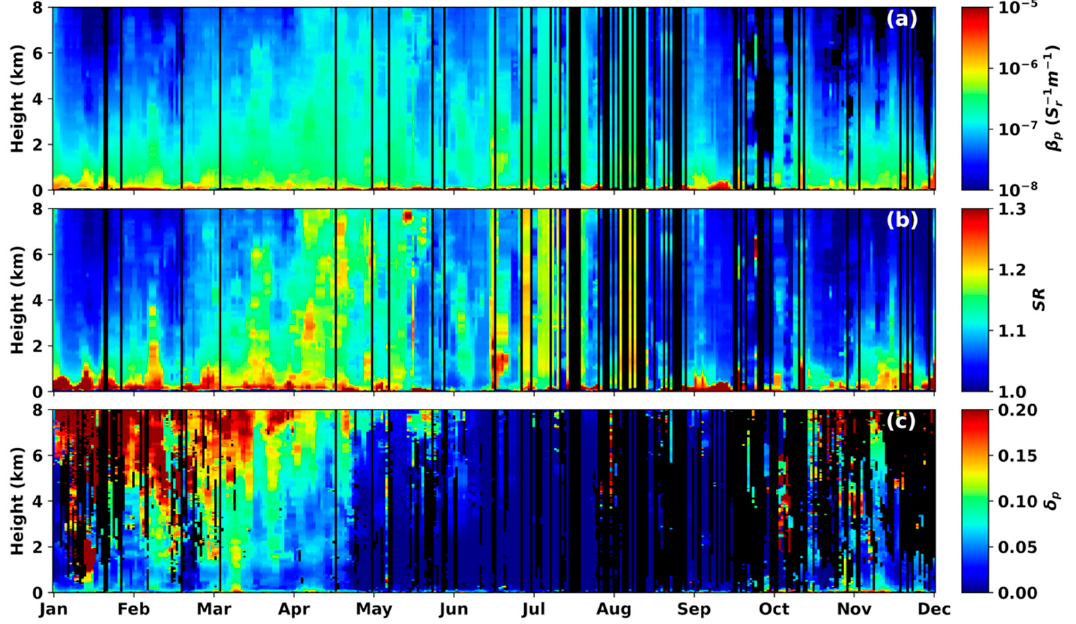
Figure 7. The annual cycle of aerosol vertical distributions in terms of multi-year daily-averaged profiles of ( a ) β p ; ( b ) SR ; ( c ) δ p